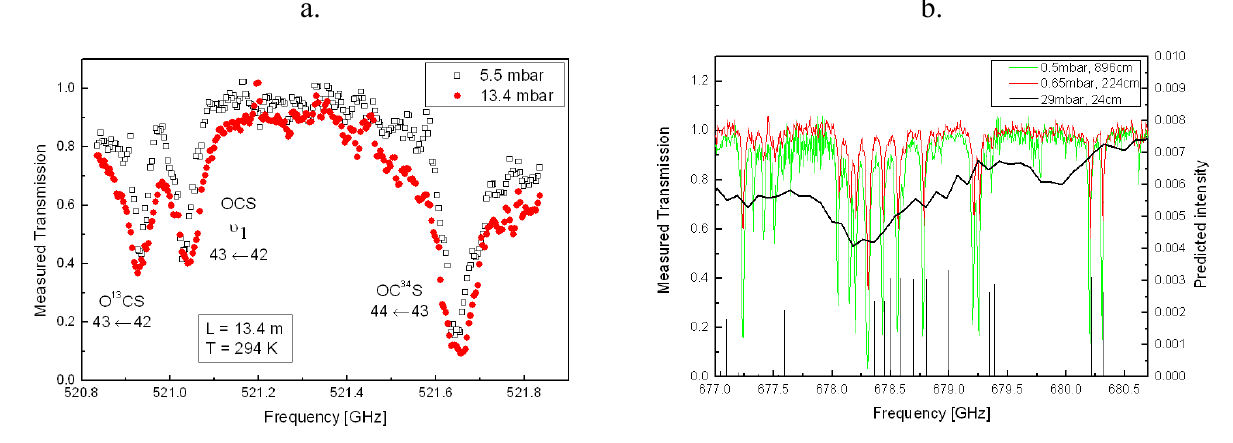
Figure 3. a.) Rotational transitions of OCS isotopologues, L = 13.4 m, T = 294 K.b.) Spectra of vinyl chloride at ambient temperature for various path lengths. Black line 24 cm. Red line 224 cm. Green line 896 cm. Black sticks indicate the predicted transition frequencies and relative intensities for the 35 Cl isotopologue calculated from the spectroscopic parameters fitted elsewhere